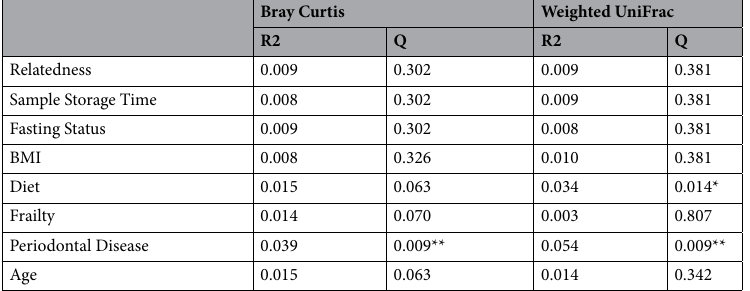
Table 3. Oral health subsample PERMANOVA including participants with data for periodontal disease (n = 134). In this subsample, an association of saliva microbiota beta diversity with periodontal